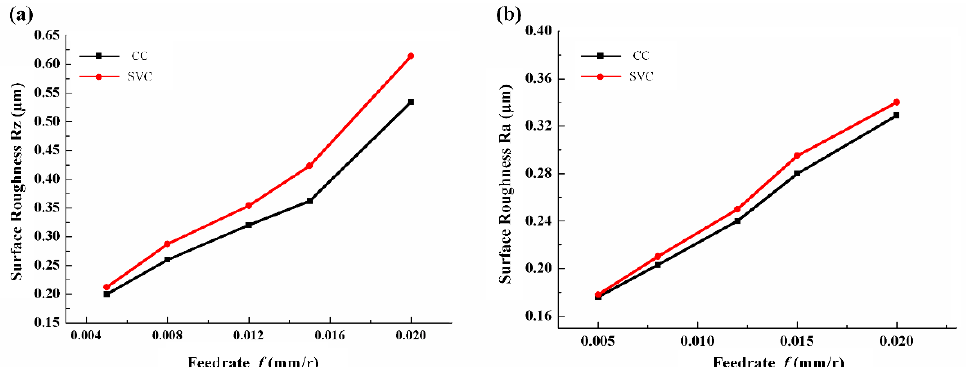
Figure 10. Surface roughness ( a ) R z and ( b ) R a vs. feed rate (cutting speed, 200 m/min; depth of cut, 0.05 mm).